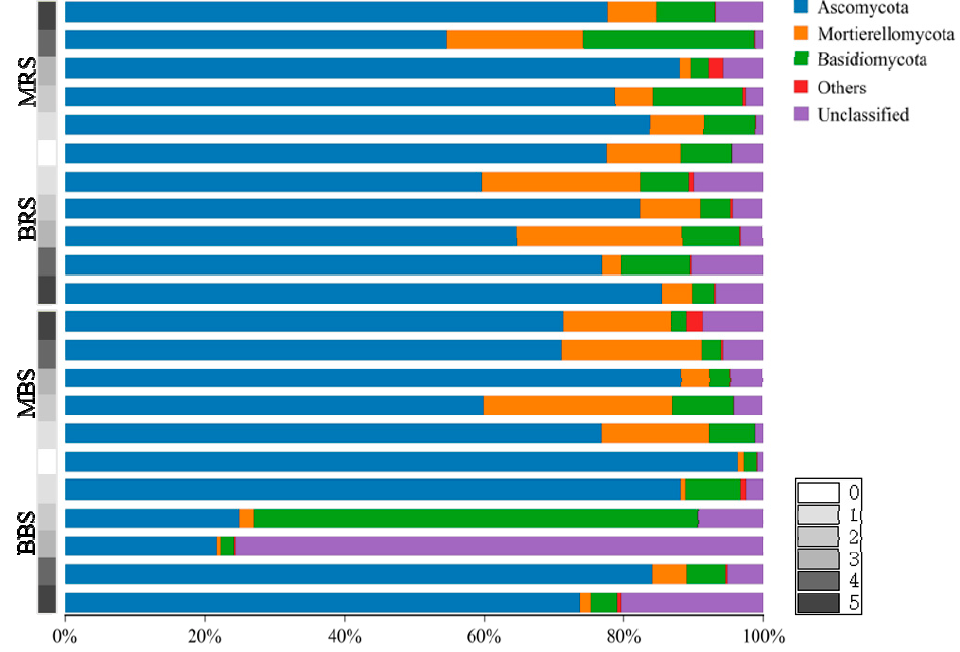
9 of 21 Figure 3. The relationships of microbial alpha diversity and chemical properties of the soil. ( A ) The